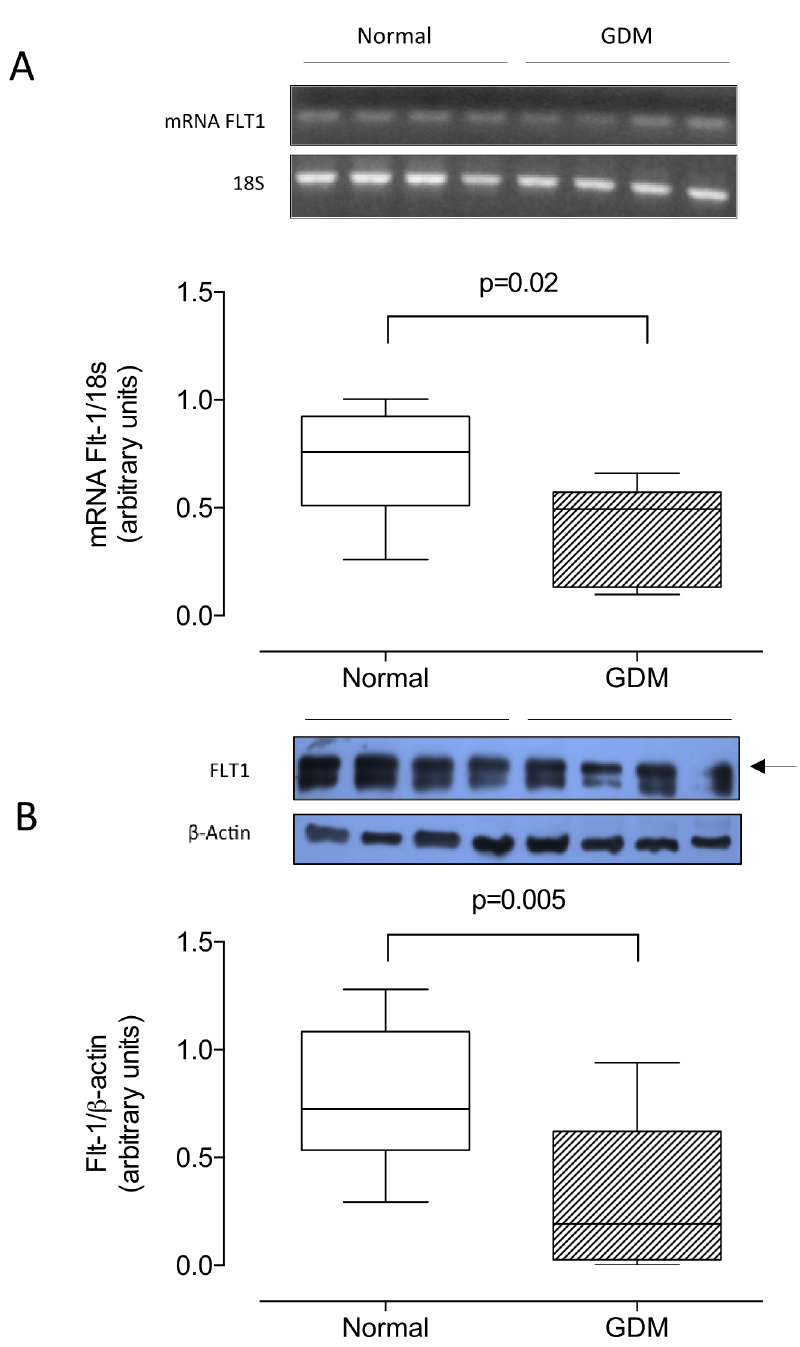
Fig 3. Placental Flt-1. A) mRNA levels for Flt-1 in total placentalhomogenate (n = 8 in each group) from normalpregnancies(Normal, white bar) or gestational diabetesmellitus (GDM, hatchedbar). Values are expressedas ratio mRNA Flt-1/18S obtainedby densitometric analysis. B) Western blot of Flt-1 (210 kDa) and β -actin(43 kDa). The bottom panel shows the results of densitometric scanningexpressed as Flt-1/ β - actin ratio; n = 15 in each group. P-value is indicatedin each